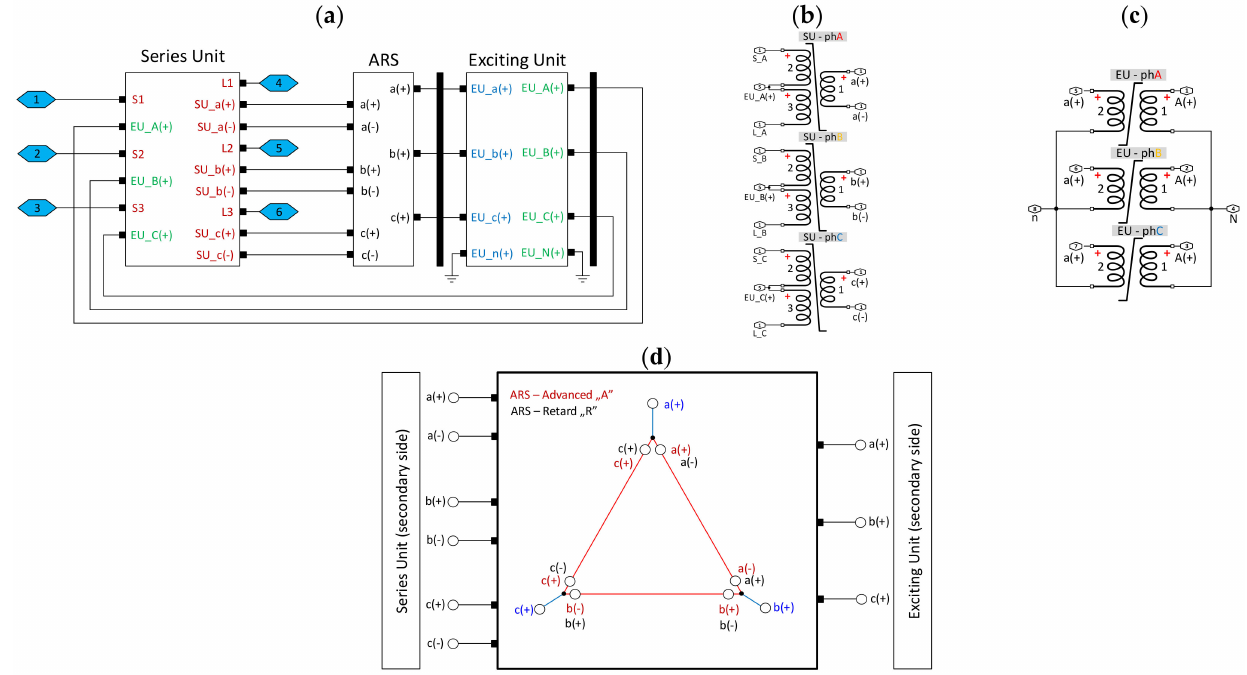
Figure 15. ( a ) General view of the PST to be modelled and internal layout of the model for ( b ) serial unit, ( c ) add-on unit, ( d ) ARS switch.